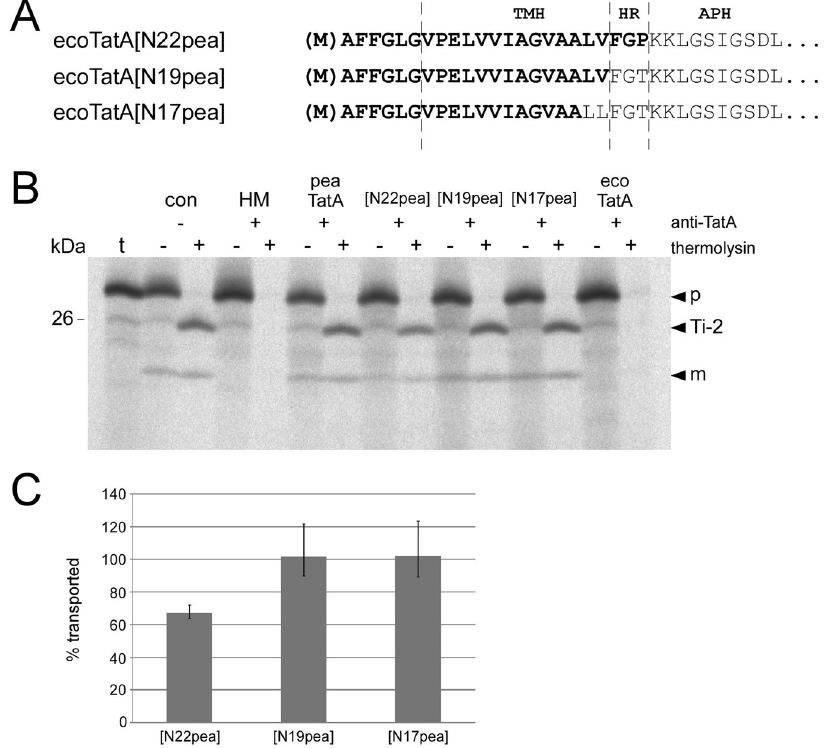
Figure 4. Catalytic activity of chimeric TatA proteins in in thylakoido complementation experiments. ( A ) Amino acid sequence of the N-terminal regions of the chimeric TatA proteins ecoTatA[N22pea], ecoTatA[N19pea], and ecoTatA[N17pea]. The residues derived from pea are depicted in bold. Please note that due to the use of E. coli TatA as reference the number of pea residues in each chimera is actually two residues higher than depicted in the name (see also Fig. 1). ( B ) In thylakoido complementation of 16/23 transport by the RTS-generated chimeric TatA proteins shown in ( A ). For further details see the legends to Figs 1 and 2. ( C ) Quantitation of catalytic activities as shown in ( B ) given as percentage of the transport rate determined for the antibody-treated assays supplemented with pea TatA. Both mean values and standard deviations from three (n = 3) independently repeated experiments are